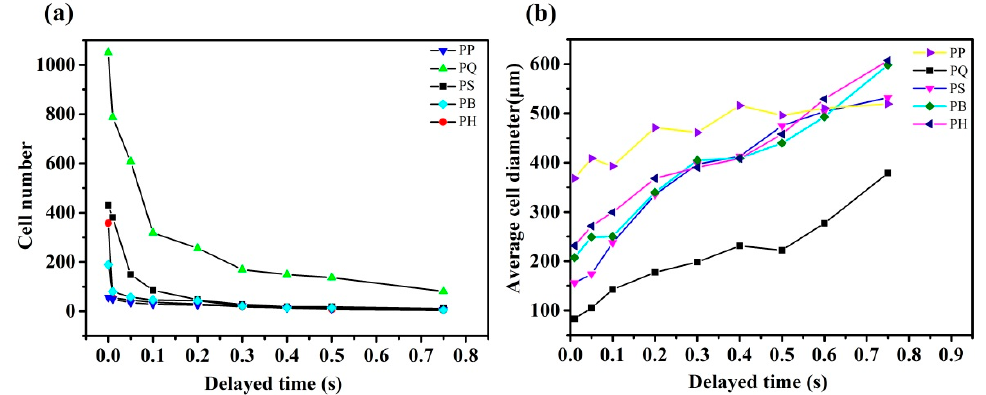
Figure 15. The cell number ( a ) and cell density ( b ) of the foamed PP composite with different mold opening times.